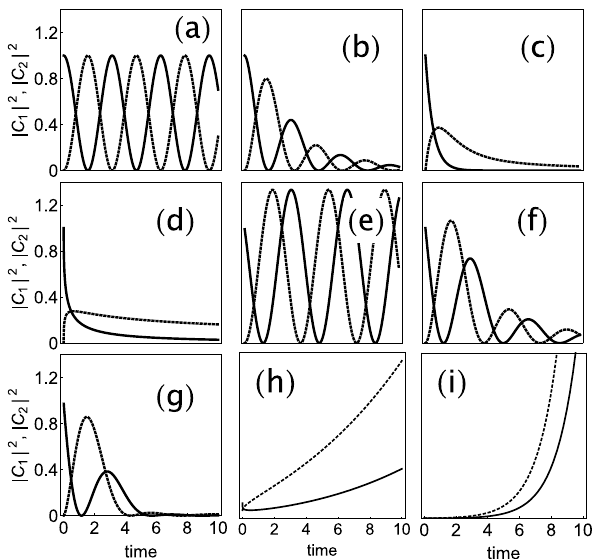
2 (continuous line) and φ 1 ( z ) Figure 3. Dimer amplitudes | | 0, σ 0 ) for several fractional derivative orders and various gain/loss parameters. ( a ) α ( γ = �= 0.9, σ 0 , ( c ) α 0.5, σ 0 , ( d ) α ( b ) α = = = = α 0.8, σ 0.5 , ( h ) α 0.25, σ 1.1 , ( i ) α = = = =